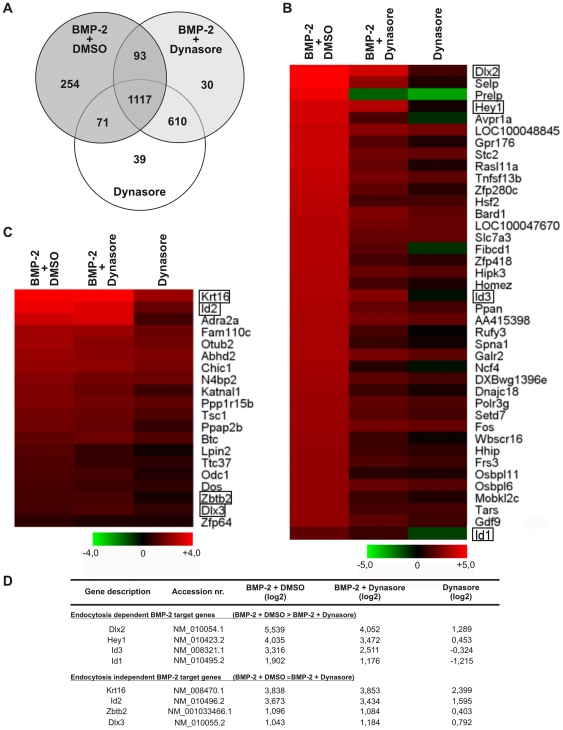
Gene expression is differentially affected by inhibition of dynamin-dependent endocytosis.Serum-starved C2C12 cells were treated for 2 h with 40 µM dynasore or 0.05% DSMO prior to stimulation with 30 nM BMP-2 for 6 h in medium containing dynasore or DMSO. RNA was isolated and subjected to whole genome profiling using the Illumina BeadChip system. Expression profiles were analyzed relative to DMSO control treatment. (A) Venn diagram based on significantly detected genes (1.4 fold regulation, detection P-value<0.05) (the entire gene list is depicted in Table S2). (B) Heatmap depicting a subset of BMP-2-induced genes, which are endocytosis-dependent (the complete list is given in Table S3). (C) Heatmap depicting BMP-2-induced genes which are endocytosis-independent (the gene list is shown in Table S4). (B,C) The heatmaps are colored by log2 expression signals according to the color key at the bottom. (D) Selected genes from lists representing endocytosis-dependent or -independent genes displayed in Table S3 and S4, respectively.